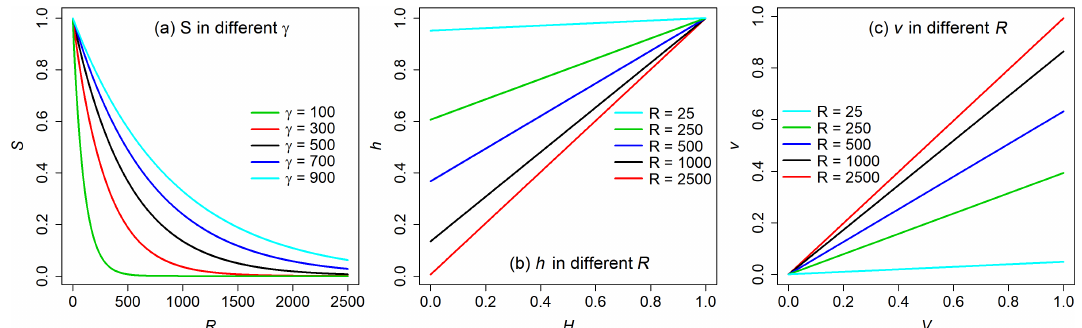
Figure 4. (a) Scale factor ( S ) decreases with increasing elevation range ( R ) by using different γ values. Fraction influence of surface effect on T ( h ) increases with hypsometric position ( H ) and strength of CAP ( v ) increases with the normalized multiresolution valley bottom flatness ( V ). γ is 500 in panels (b, c) . The lowest point in the landscape always receives a weight of 1 in h and a weight of 0 in v .